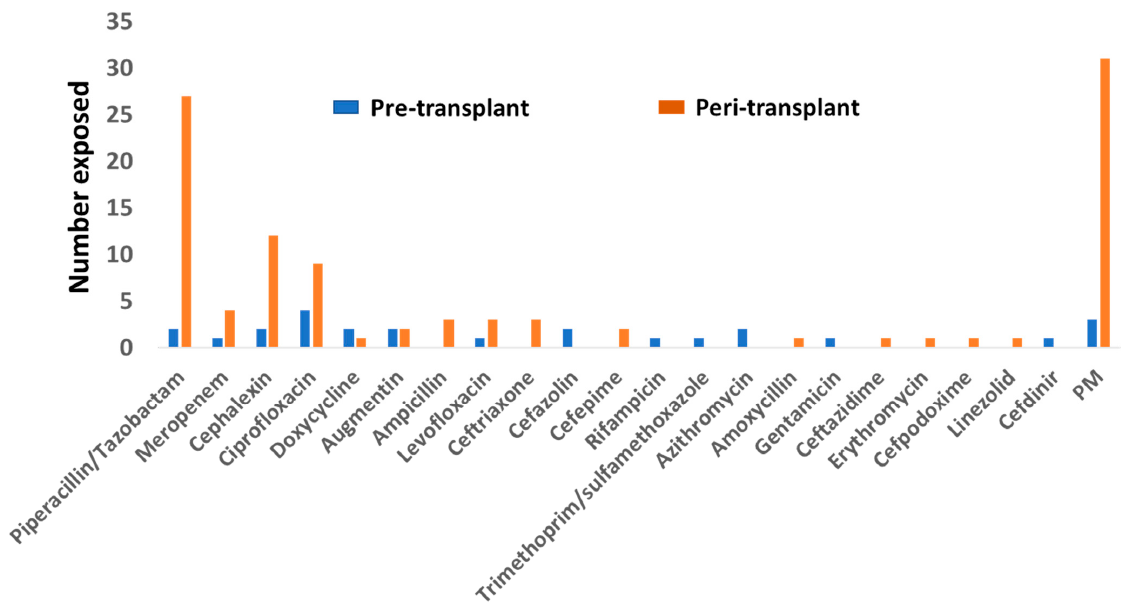
Figure 1. Antibiotics used on the patients within two months of transplant or during the peri-transplant period. The top three antibiotics were piperacillin/tazobactam, cephalexin, and ciprofloxacin. (PM = piperacillin/tazobactam + meropenem). Table 2. Indications for the use of broad-spectrum antibiotics.